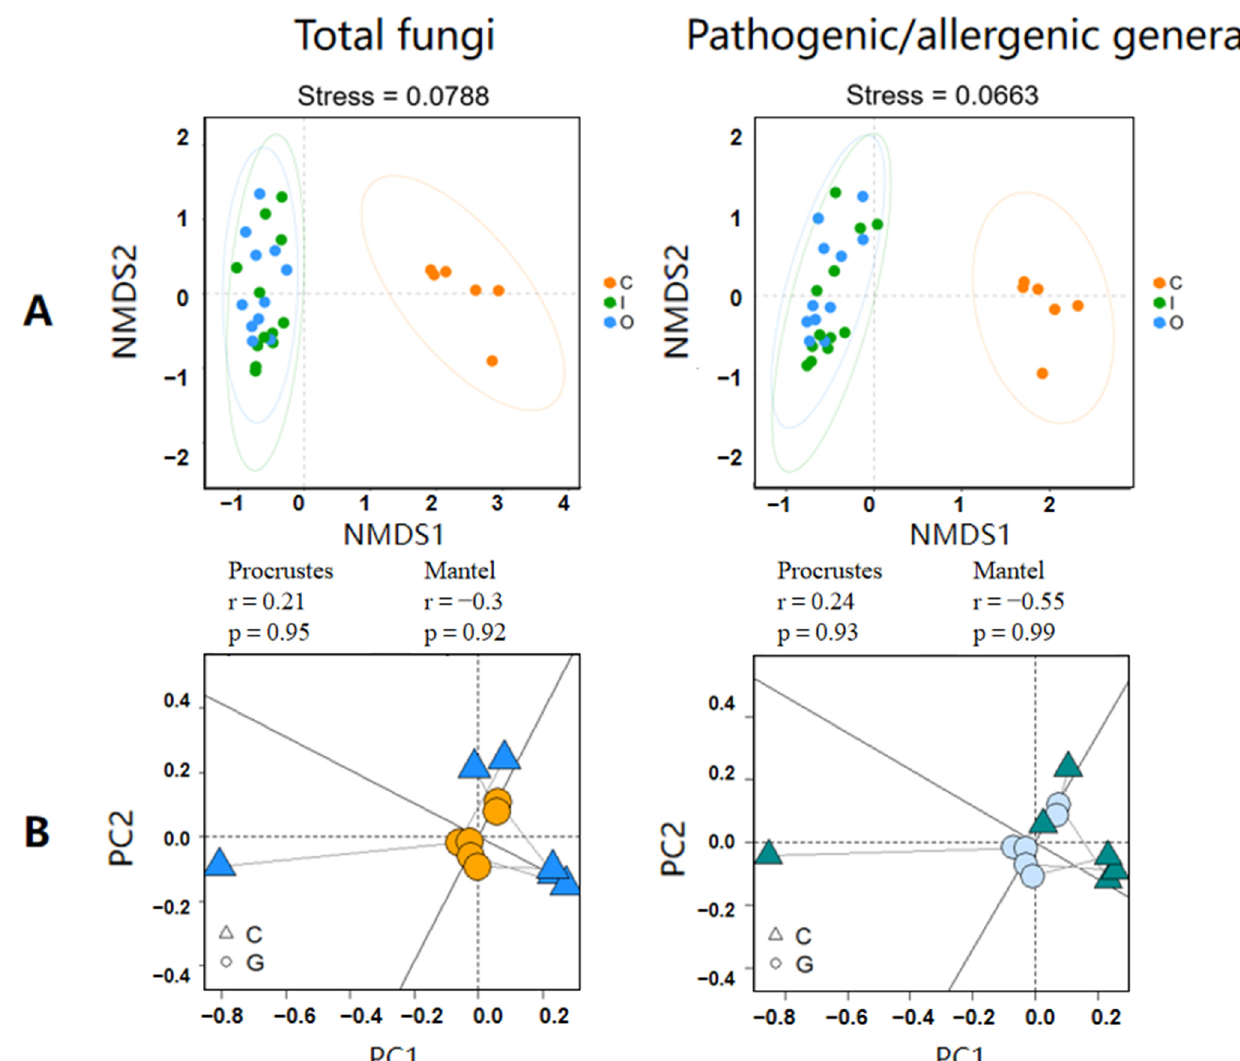
Figure 3. Relation of fungal community between composting piles and air by total fungal genera and pathogenic/allergenic genera. ( A ), fungal lineages used non-metric multidimensional scaling analysis (the orange point represents compost piles, the green represents the inside, and the blue represents outside air of composting workshop); ( B ), fungal community correlation used Procrustes and Mantel analysis (the triangle represents compost piles, and the circle represents the air sample).